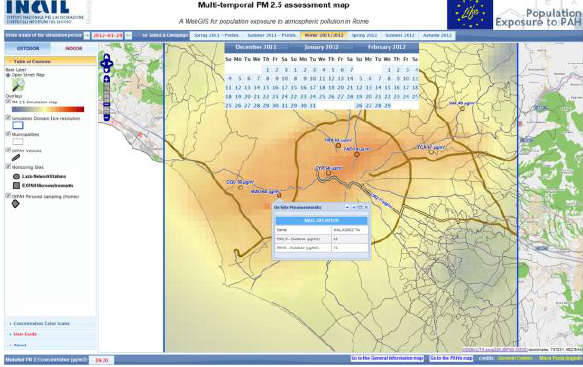
Figure 4. Screenshot of the multi-temporal web map illustrating results of PM2.5 assessment and modeling.